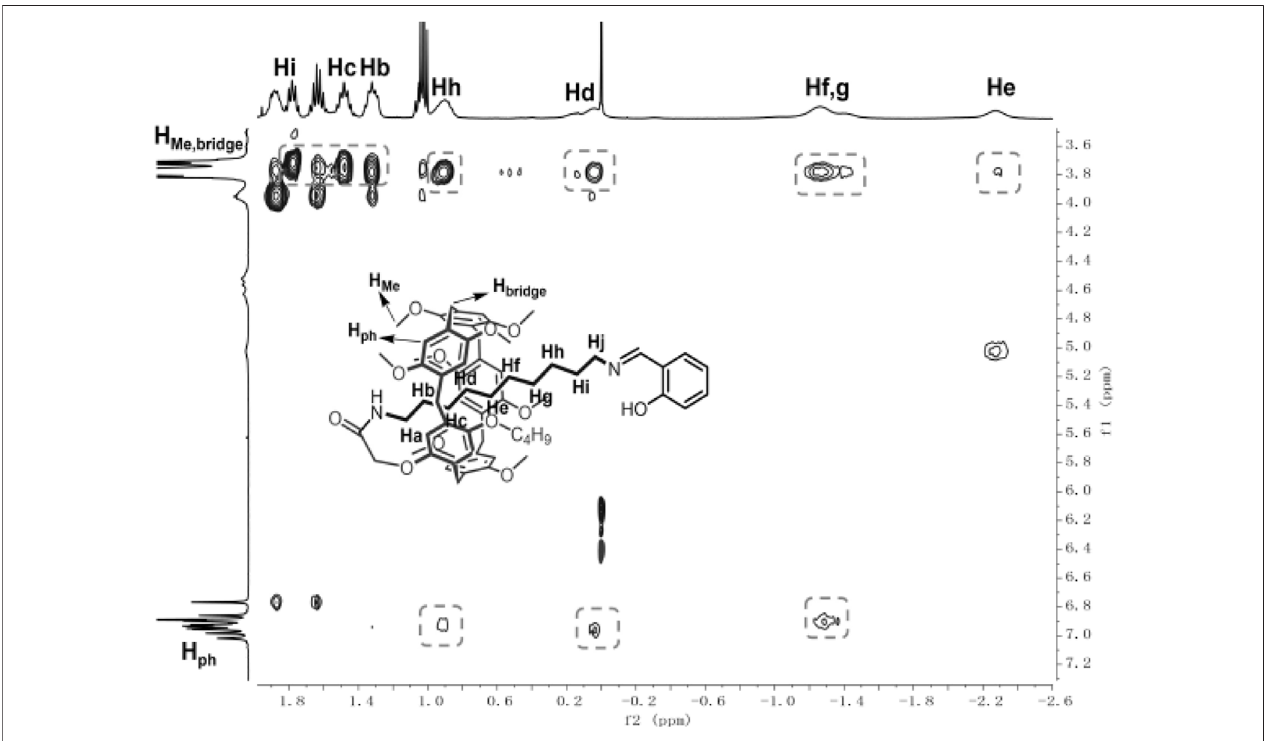
FIGURE 2 | Partial 2D NOESY spectrum of a CDCl 3 solution of 6e at